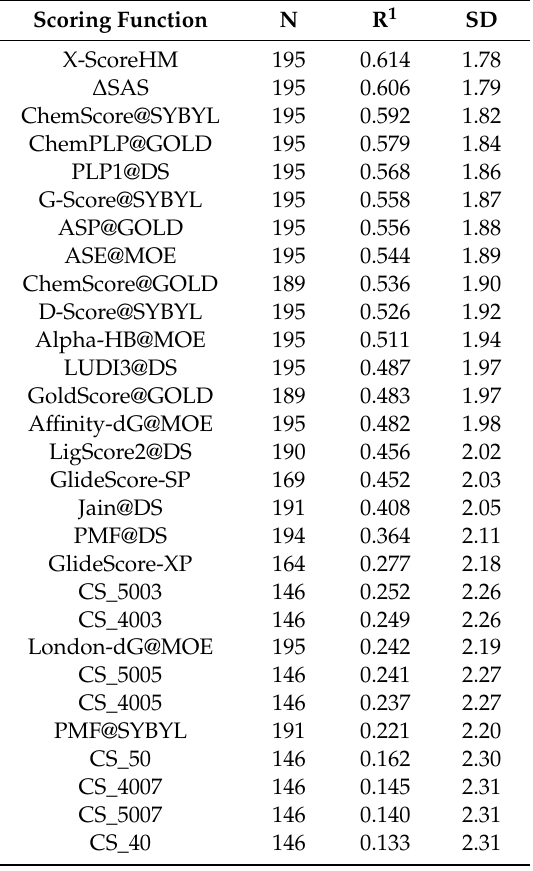
Table 4. Performance of the scoring functions in the scoring power test. Scoring functions are ranked based on the Pearson correlation coe ffi